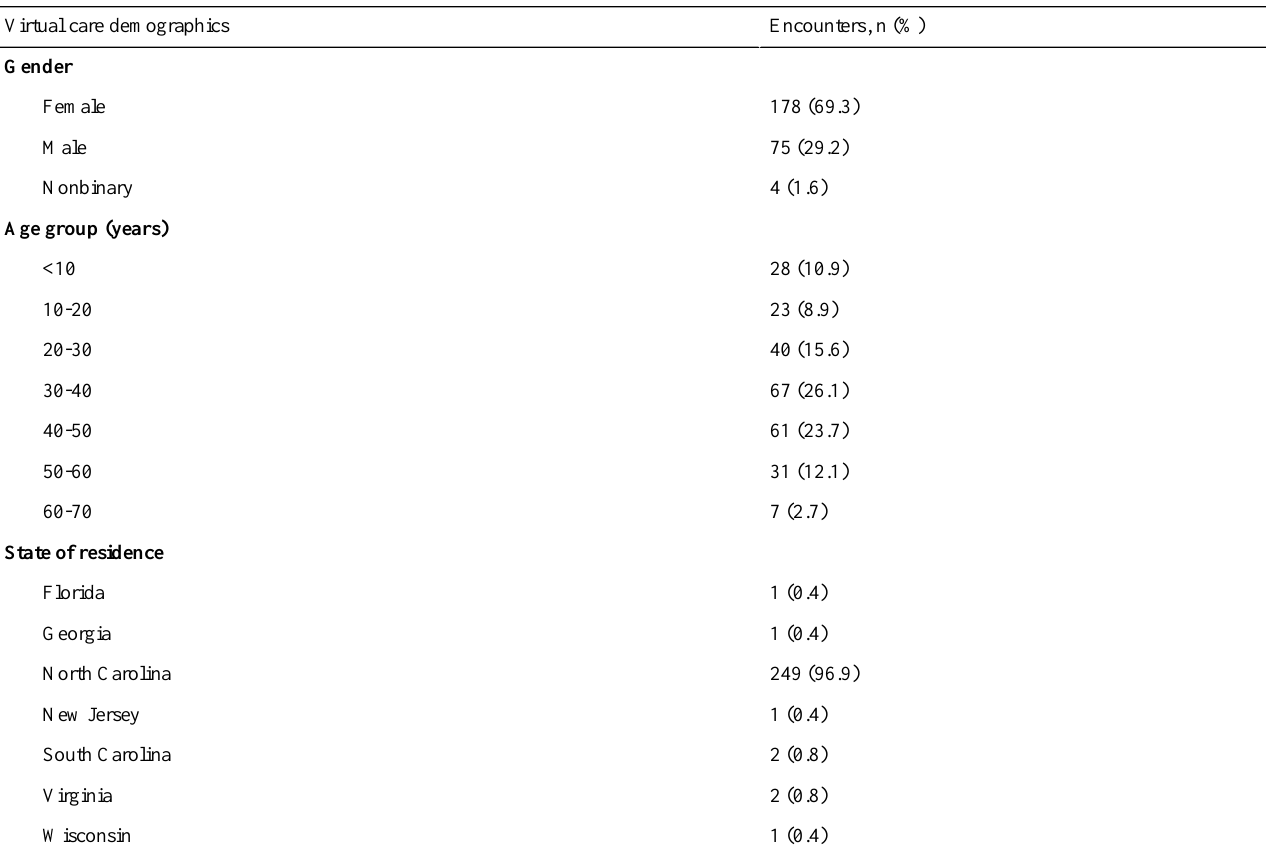
Table 1. Summary of Characteristics of Virtual Care Patients with COVID-19 Symptoms